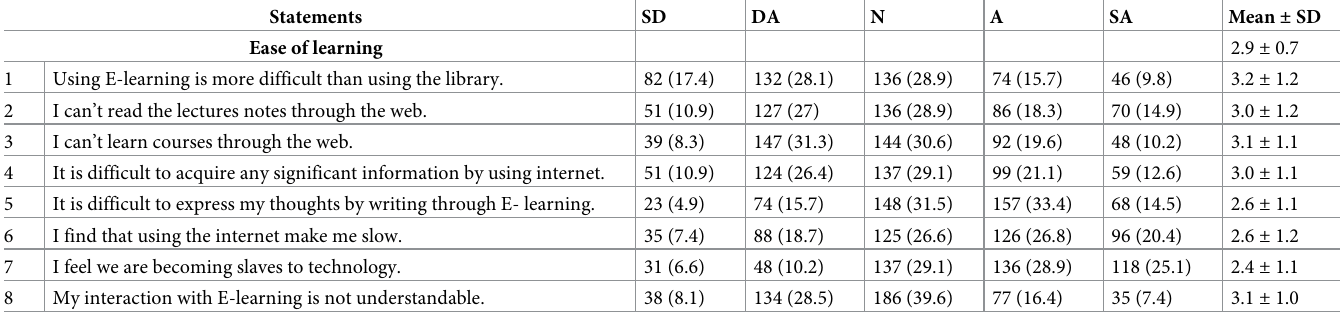
Table 5. Ease of learning (n =